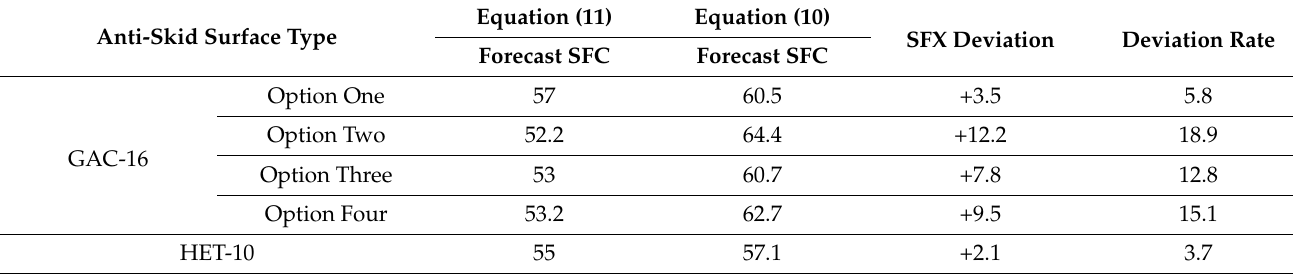
Table 12. Comparison of the prediction results of the two